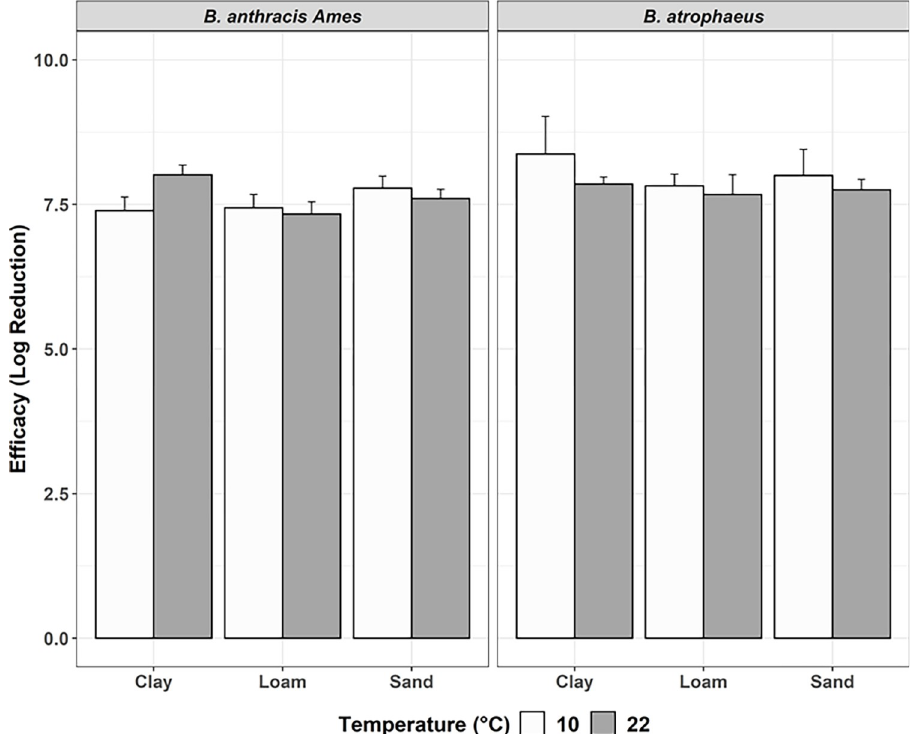
Fig 4. Efficacy of 2 mL of 2.5% formaldehyde, covered, at 10˚C (white; Test 5) vs. 22˚C (gray; Test 4). Tests conducted against B . a . and B . atrophaeus , with efficacy represented by log reduction ( ± 95% CI) of bacteria, by soil type, and 48-hour contact time. Columns with stripes are samples that did not achieve complete